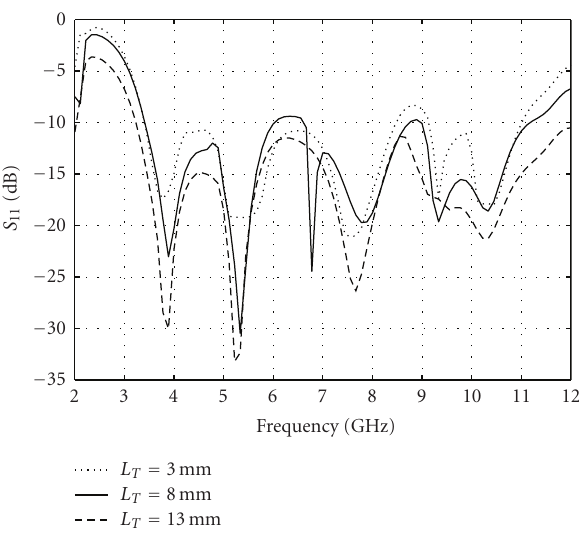
Figure 3: E ff ect of L T changes on return loss. L T is the distance between the center of the cross-slot and the square ring.